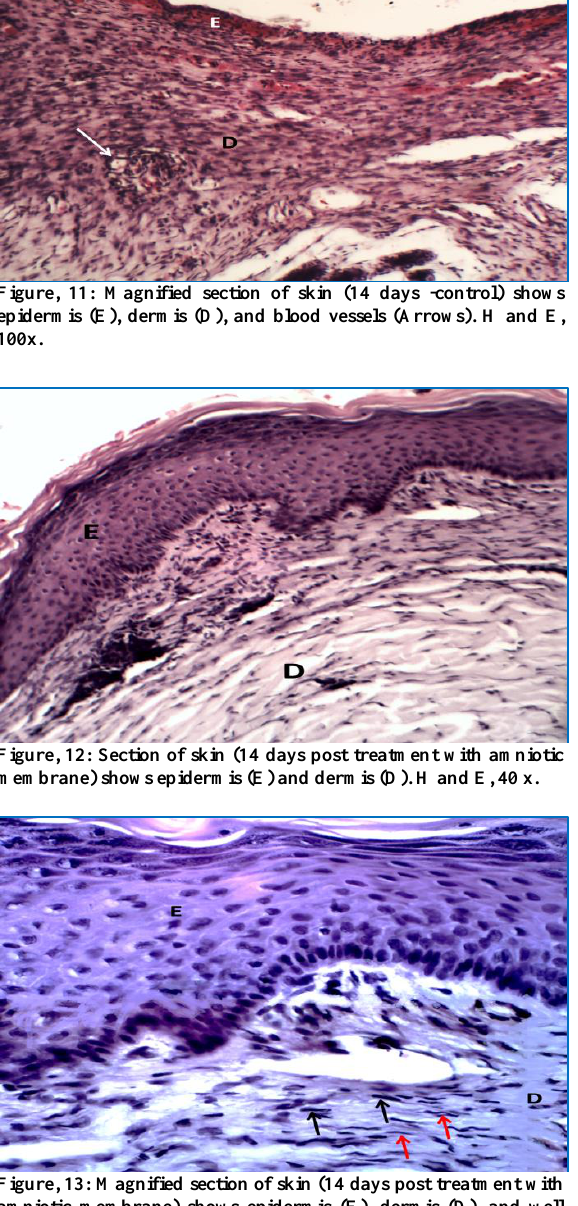
Figure, 9: magnified of skin (7 days post treatment with pericardial craft): Inflammatory zone composed of polymorphic nuclear cells (PMNs) and fibrin deposit (Fi). H and E stain, 400x.